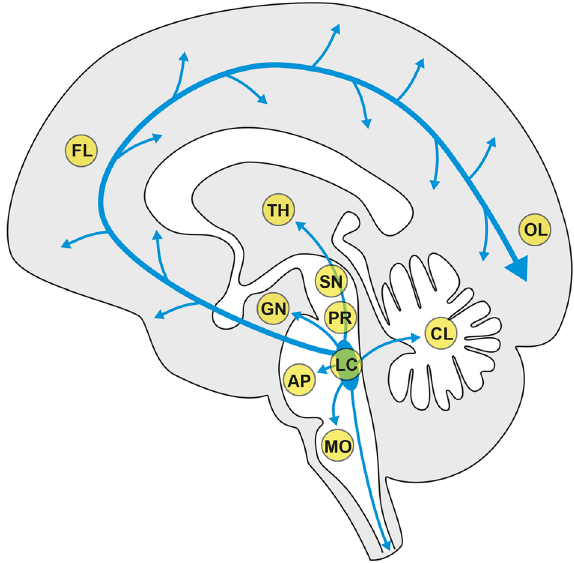
Figure 3. Location of brain regions where results are illustrated in the figures that follow. AP anterior pons (Figs. 4, 5, 6, 8, 9), CL cerebellum (Fig. 7), FL frontal lobe (Figs. 5, 6), GN lateral geniculate nucleus (Fig. 5), LC locus ceruleus (Figs. 4, 8, 9), MO medulla oblongata (Fig. 7), OL occipital lobe (Figs. 5, 6), PR pontine midline raphe (Fig. 7), SN substantia nigra (Fig. 4), TH thalamus (Figs. 5, 7). The blue arrows indicate the extent of locus ceruleus output of noradrenaline to the cerebrum, brain stem, cerebellum, and spinal cord. Diagram adapted from Bari et al. 2020 62